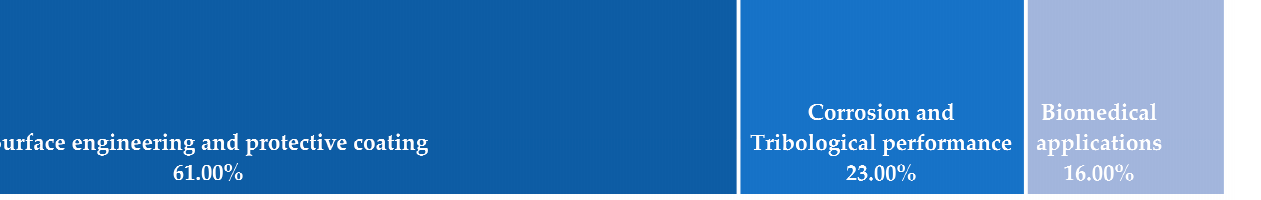
Figure 28. Contribution of EDM in different applications (found in different publications reviewed in this study).